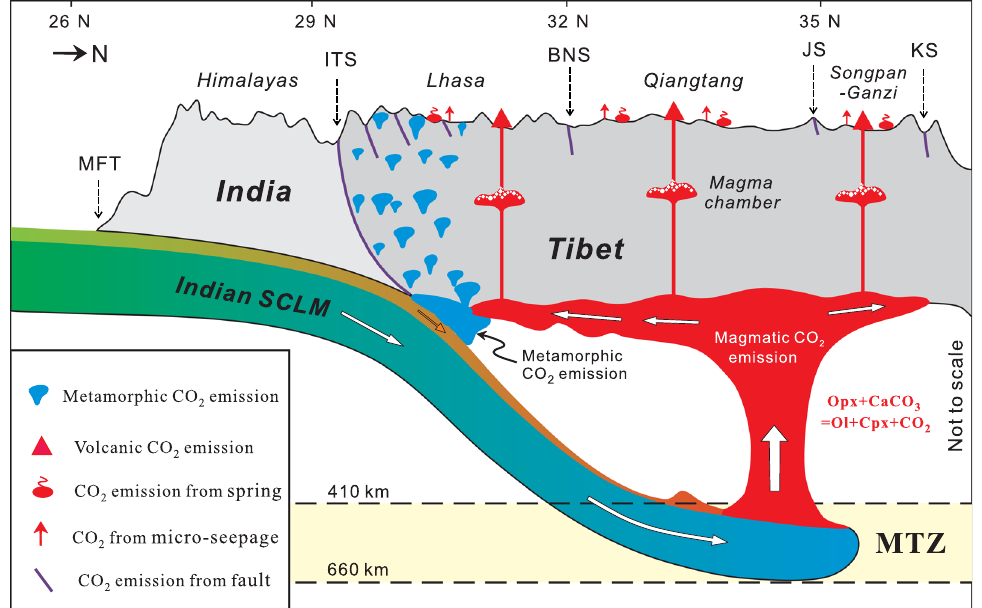
Fig. 8 Major types of continental collision-derived CO 2 degassing, including metamorphic and magmatic CO 2 emissions in Tibet. Magmatic CO 2 emissions are composed of Cenozoic volcanic activity-induced CO 2 emissions and the present CO 2 degassing from the hydrothermal systems (e.g., hot spring, fault and soil micro-seepage) related to dormant volcanic fi elds in the Plateau. MFT main frontal thrust, MTZ mantle transition zone, SCLM sub- continental lithospheric mantle. ITS, BNS, JS, and KS are as in Fig.